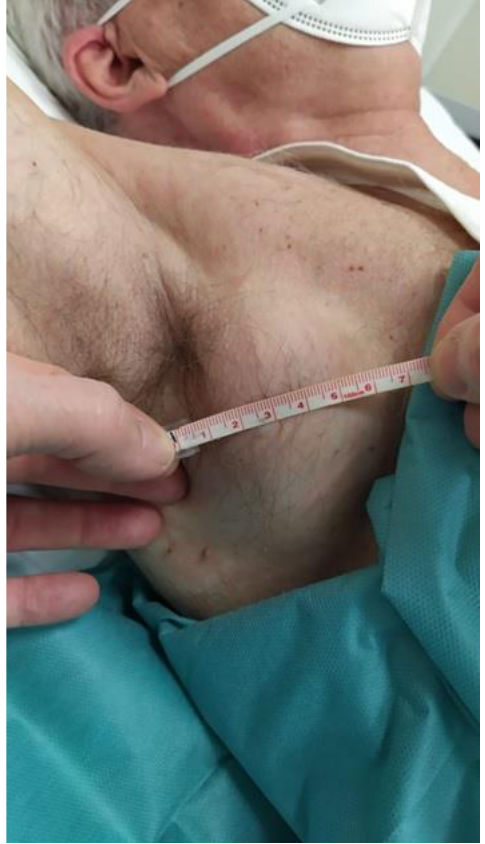
Figure 1. Physical examination revealed a large right axillary adenopathy. The lymphadenopathies were painful and mobile. A total body computed tomography (CT) examination confirmed the two lymphadenopathies, measuring 6.99 cm and 2.36 cm, respectively (Figure